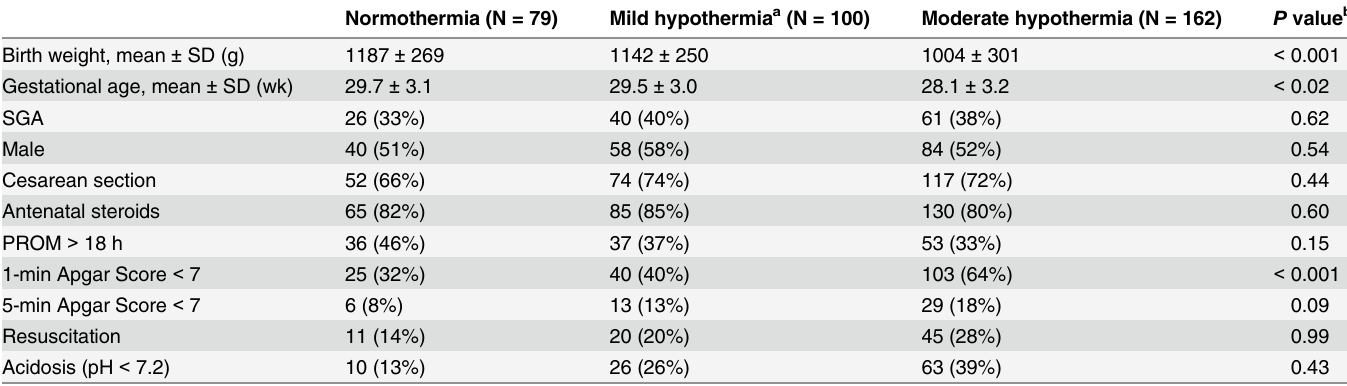
Table 1. Comparison of maternal and infant variables among groups.